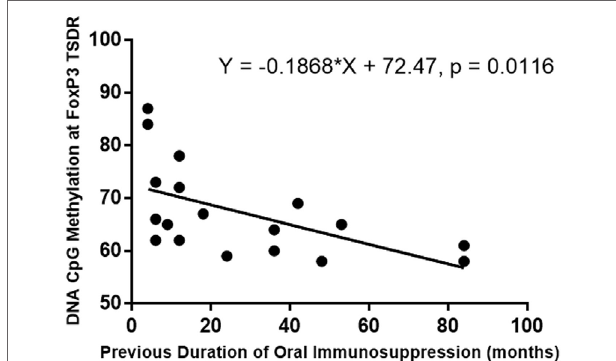
FigUre 9 | Simple linear regression of the duration of the previous oral immunosuppression treatment (months) and DNA methylation of FoxP3 Treg-specific demethylated region (TSDR). Previous duration of oral immunosuppressive treatment negatively correlated with DNA methylation at FoxP3 TSDR, and this relationship was significant ( P = 0.012) when modeled with a simple linear